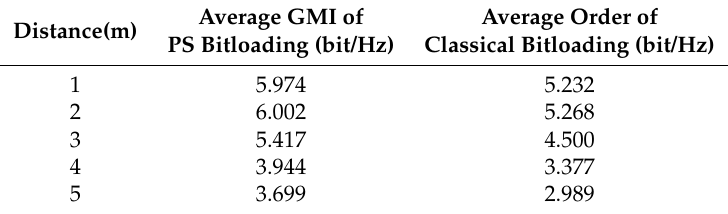
Table 3. The information entropy in each subcarrier of PS bitloading and classical